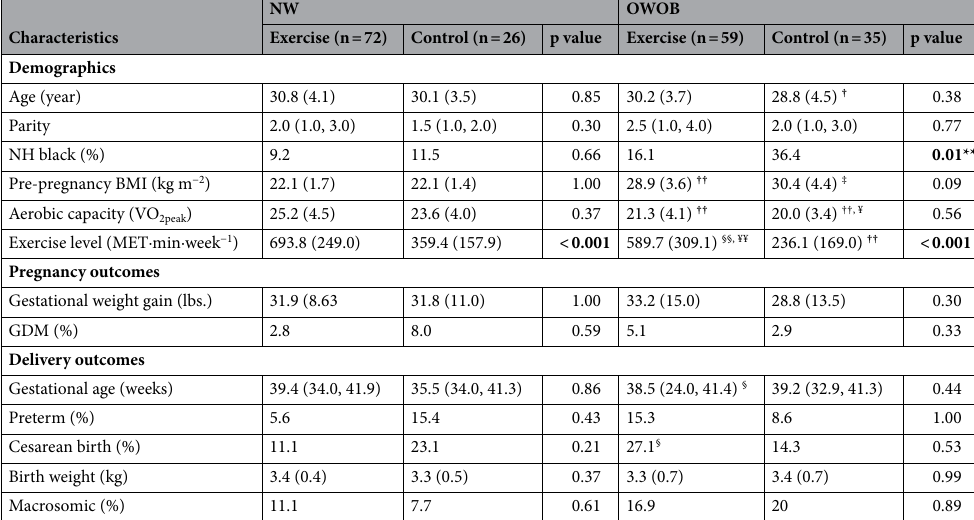
aerobic capacity, exercised less, and had higher rates of cesarean birth relative to the NW exercisers (Table 2). Per protocol analysis outcomes. For per protocol analysis of those exercise adherent, OWOB exercisers were, on average, Caucasian, had a lower pre-pregnancy BMI (28.5 vs 30.4 kg m −2 ) and higher pre-pregnancy aerobic fit- ness (22.0 vs 20.0 ml O 2 ∙kg −1 ∙min −1 ) relative to OWOB controls (Table 3). For per protocol analysis of those exer- cise adherent, significant between-group differences were observed for maternal age, race, pre-pregnancy BMI, and aerobic capacity where women in the exercise group were, on average, older (31.1 vs 29.4 years), Caucasian, had a lower pre-pregnancy BMI (24.6 vs 26.8 kg m −2 ) and higher fitness level (24.6 vs 21.6 ml O 2 ∙kg −1 ∙min −1 ). Though not significant, exercisers have attenuations of 2.1% of cesarean births and 3% of preterm births relative to non-exercisers (Suppl. Table 2). For the per protocol analyses, a greater proportion of all OWOB pregnant women were non-Hispanic black (22.6 vs 8.5%), less aerobically fit (21.1 vs 25.3 ml O 2 ∙kg −1 ∙min −1 ) and exerted less weekly energy expenditure (459.1 vs 626.1 MET∙min∙week −1 ). Although not significant, only 2.6% more OWOB women delivered via cesarean birth relative to the healthy BMI group; this is an attenuation of 5.4% from the intention-to-treat comparison (Suppl. Table 3). Regression analysis outcomes. Results for the effects of maternal BMI on pregnancy and delivery outcomes and the independent effect of prenatal exercise showed that, after controlling for maternal race, maternal BMI was not significantly associated with risk of non-elective cesarean birth (RR 1.63, 95% CI 0.92, 2.89) (Table 4). While the relationship remained non-significant, the inclusion of maternal exercise reduced the relative risk (RR 1.63–1.43) for the association of maternal BMI and risk of cesarean birth (Table 4). Further, after controlling for gestational age and maternal race, maternal BMI was positively associated with neonatal birth weight, where OWOB women delivered heavier neonates compared to normal weight pregnant women (β = 0.13, 95% CI 0.01, 0.25, p = 0.04). The independent effect of maternal exercise showed an increase in the difference in neonatal birth weights between OWOB pregnant women and their normal weight counterparts (β = 0.16, 95% CI 0.02, 0.29, p = 0.02), following its inclusion in the statistical model (Table 4b). Pre-pregnancy BMI (p = 0.004) and aerobic capacity (p = 0.03) are significant predictors of cesarean birth (Table 4b). Controlling for maternal age and aerobic capacity, GWG (p = 0.001), and race (p ≤ 0.0001) correlated with increased birth weight (Table 4b). Similarly, controlling for maternal age with exercise added to the model, lower aerobic capacity (p = 0.03), GWG (p = 0.002), Black race (p ≤ 0.0001) and exercise level (p = 0.03) correlated with birth weight (Table 4b). There were no significant prediction models for preterm birth.